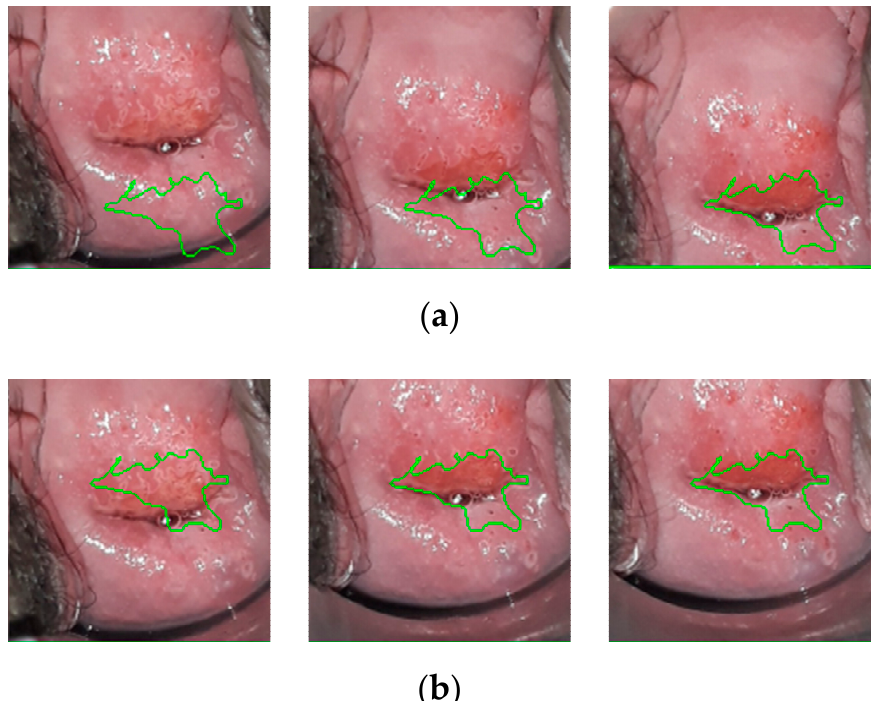
Figure 3. ( a ) Ground truth labels drawn on the first, one-minute, and last frames from a recording before motion compensation. ( b ) Ground truth labels drawn on the first, one-minute, and last frames from a recording after motion compensation.